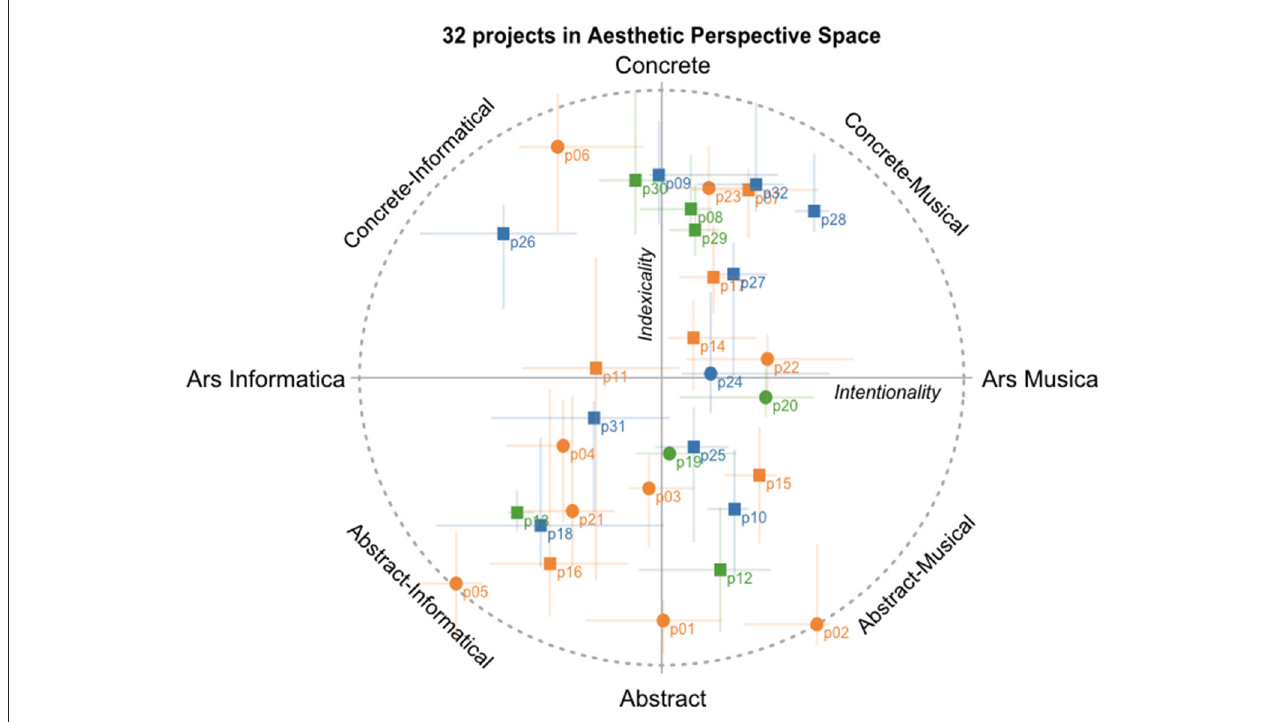
FIGURE4 Mapping of 32 projects in the Aesthetic Perspective Space: median position with lines indicating the 1st and 3rd quantiles. Circles, sonification projects; Squares, sonification-visualization projects. Colors denote topics (data provenance) as follows: orange, atmosphere, green, biosphere, blue,